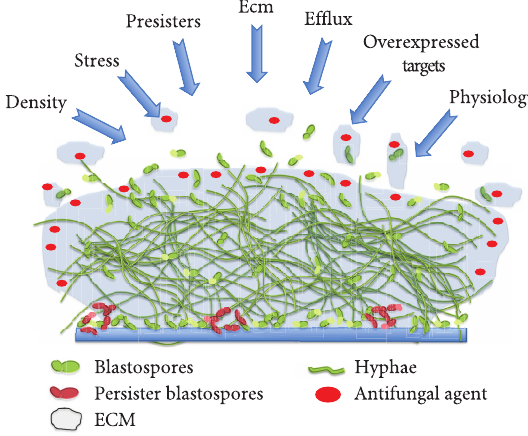
Figure 1: Schematic overview of fungal biofilm resistance mech- anisms. Generic overview of key biofilm resistance mechanisms associated with C. albicans , but which are likely to be common to other fungi. This figure illustrates the density and complexity of the C. albicans biofilm, with di ff erent morphotypes present surrounded by ECM. The arrows represent the di ff erent factors that drive antifungal resistance within the biofilm, including density, stress, persisters, ECM, e ffl ux, overexpressed targets, and the general physiology of the biofilm. These have been placed according to their contribution to resistance, with those that have a greater e ff ect closer to the middle and those with less impact at the